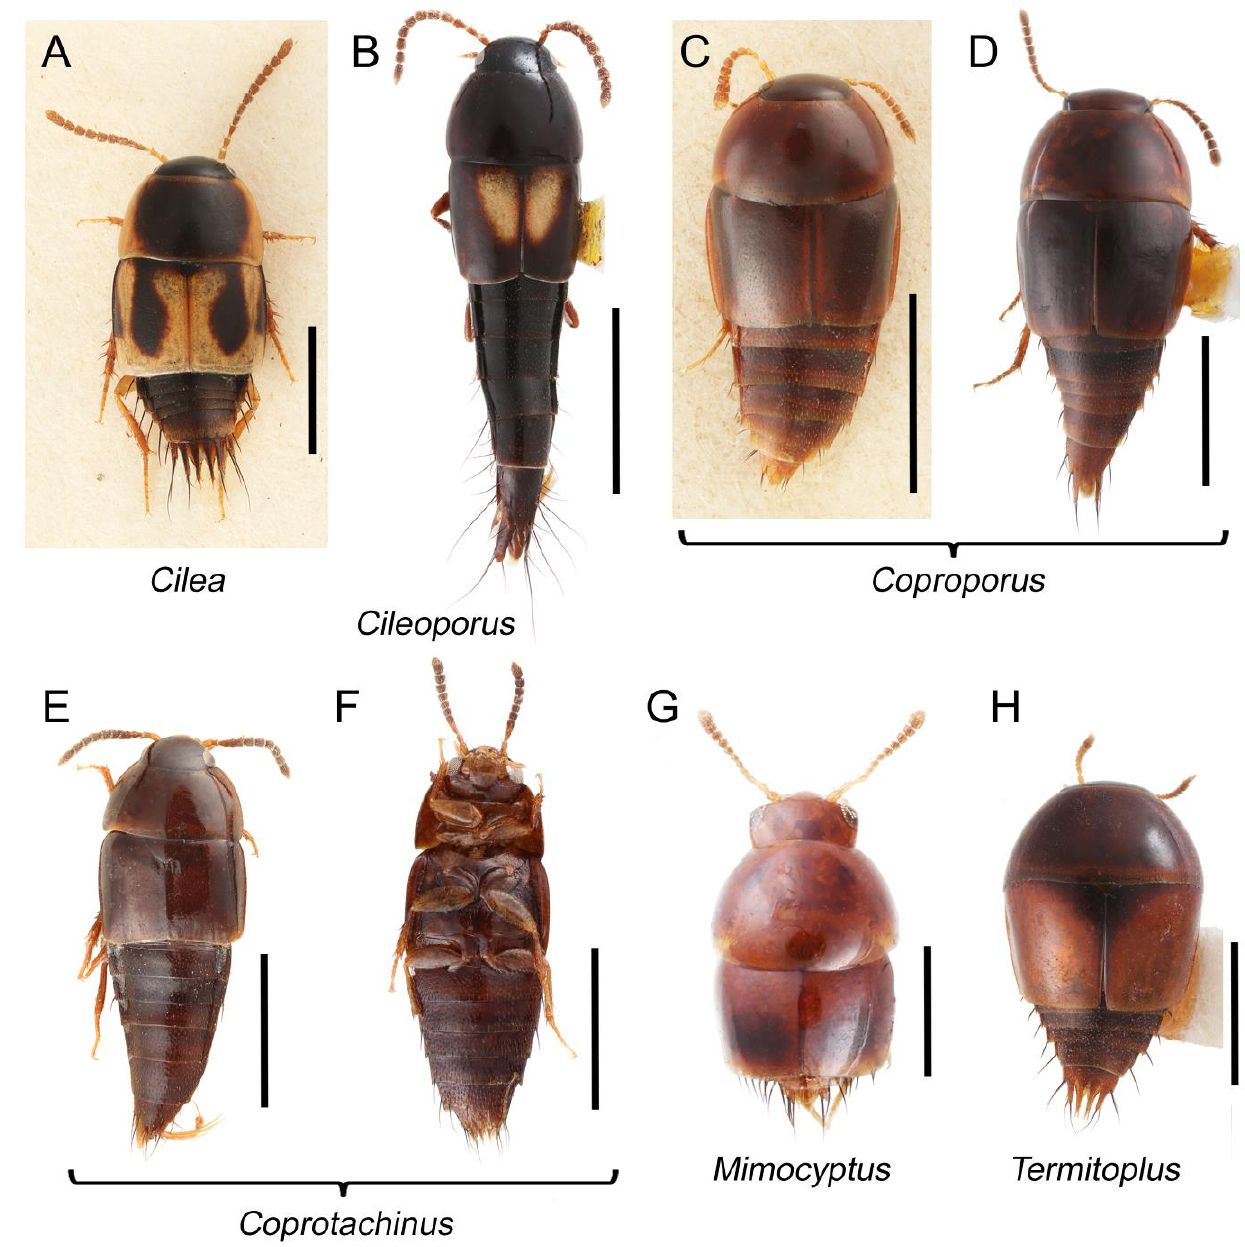
Figure 21. Habitus photographs of Vatesini. ( A ) Cilea silphoides , dorsal view. ( B ) Cileoporus fenestratus (Sharp), dorsal view. ( C ) Coproporus colchicus , dorsal view. ( D ) Coproporus laevis LeConte, dorsal view. ( E ) Coprotachinus habrocerinus (Eppelsheim), dorsal view. ( F ) Coprotachinus habrocerinus , ventral view. ( G ) Mimocyptus sp., dorsal view. ( H ) Termitoplus grandis , dorsal view. Scale bars: 1.5 mm (A,B); 1.0 mm ( C – F , H ); 0.5 mm ( G